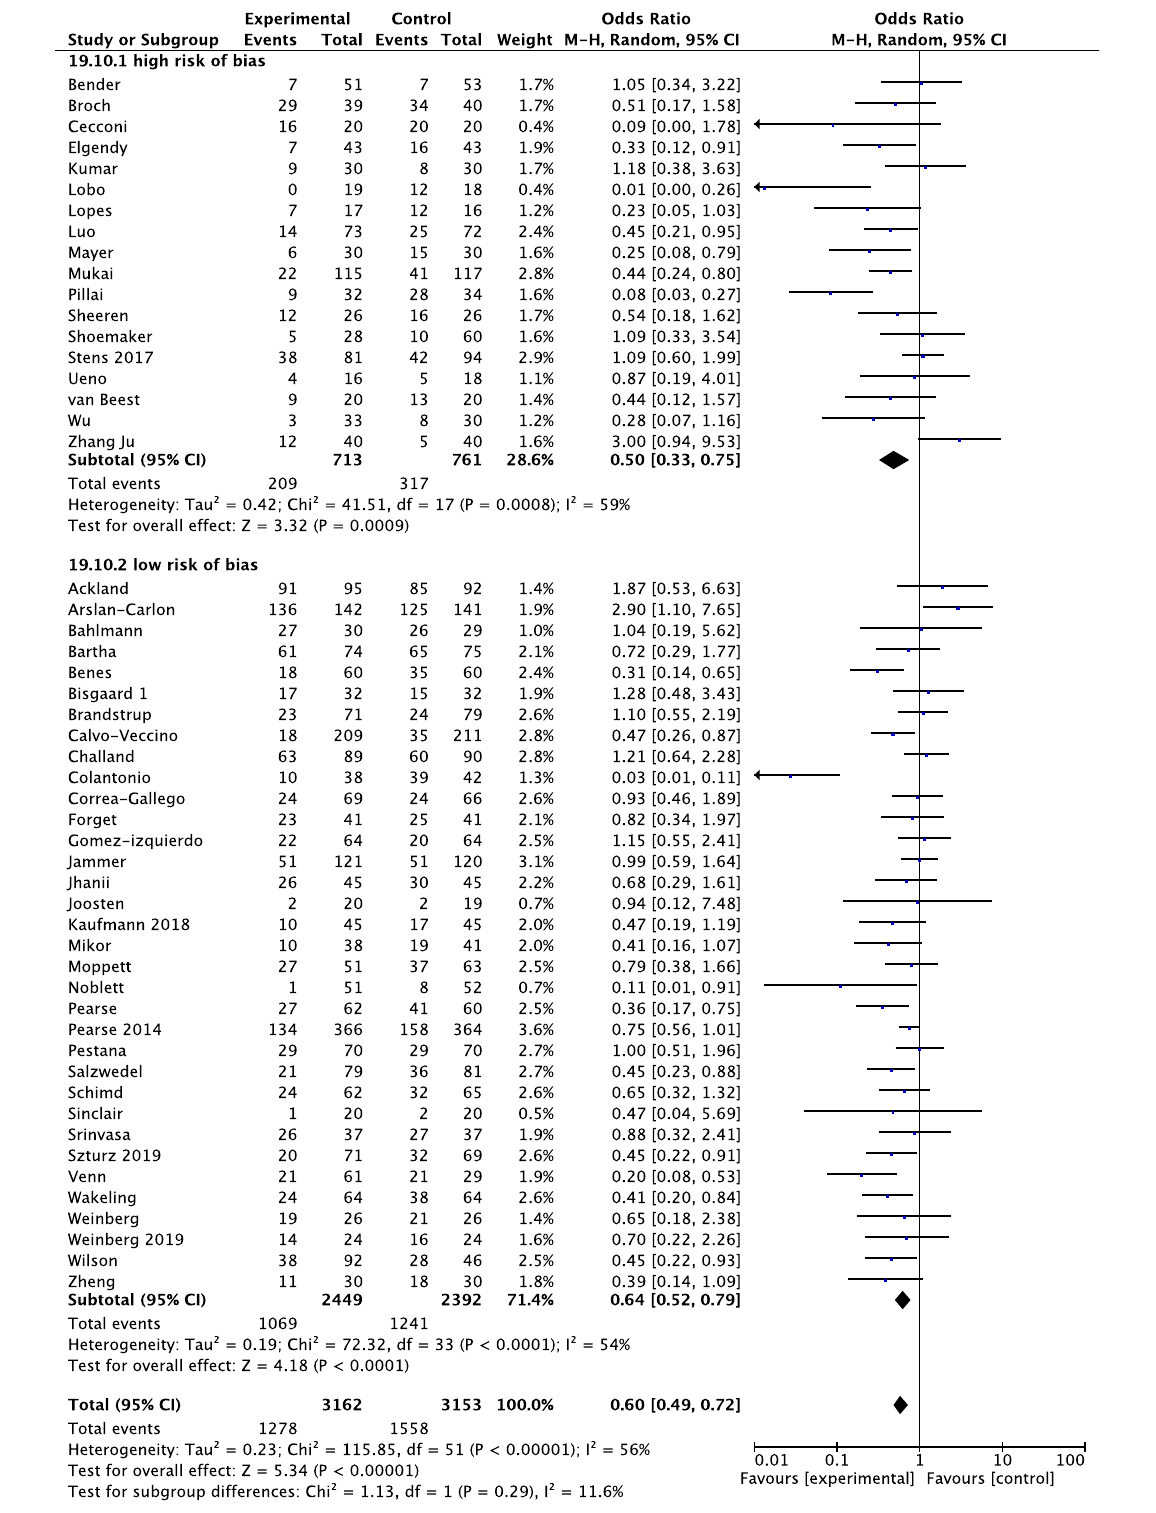
Fig. 2 (See legend on next